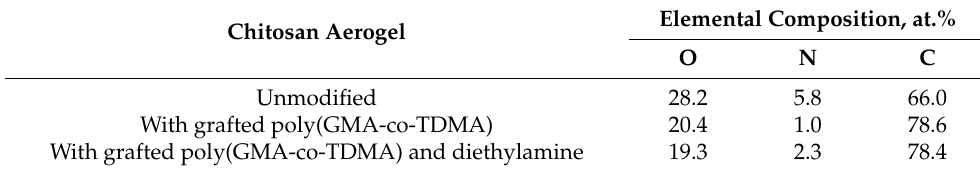
Table 4. Concentrations of constituent photoelectron regions of chitosan aerogels before and after modification obtained by the XPS method.